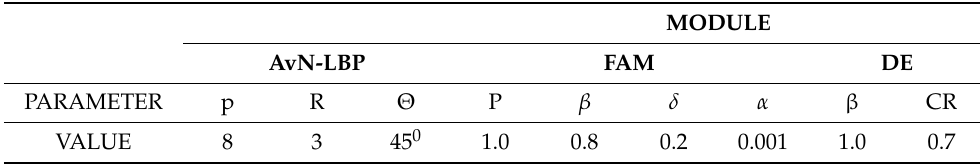
Table 1. Parameters adopted for the AvN-LBP extraction, training, and optimization of the FAM network adopted during experimentation. MODULE AvN-LBP FAM